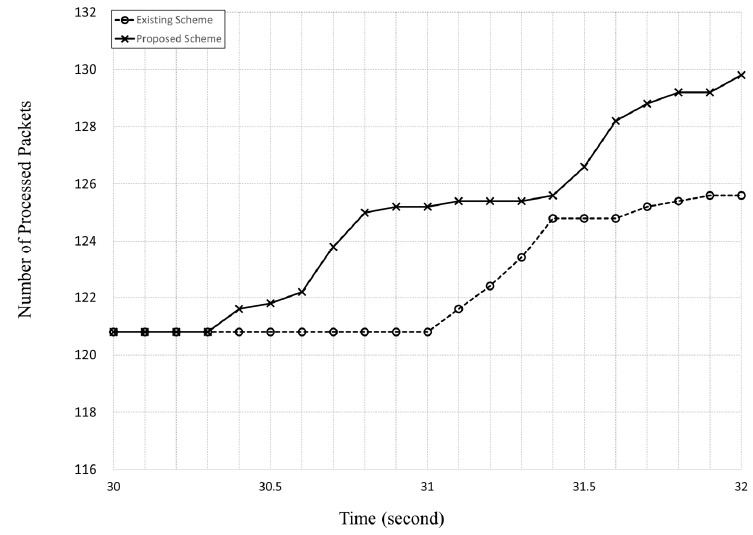
Figure 28. Analysis of packets processed during the VT handover.